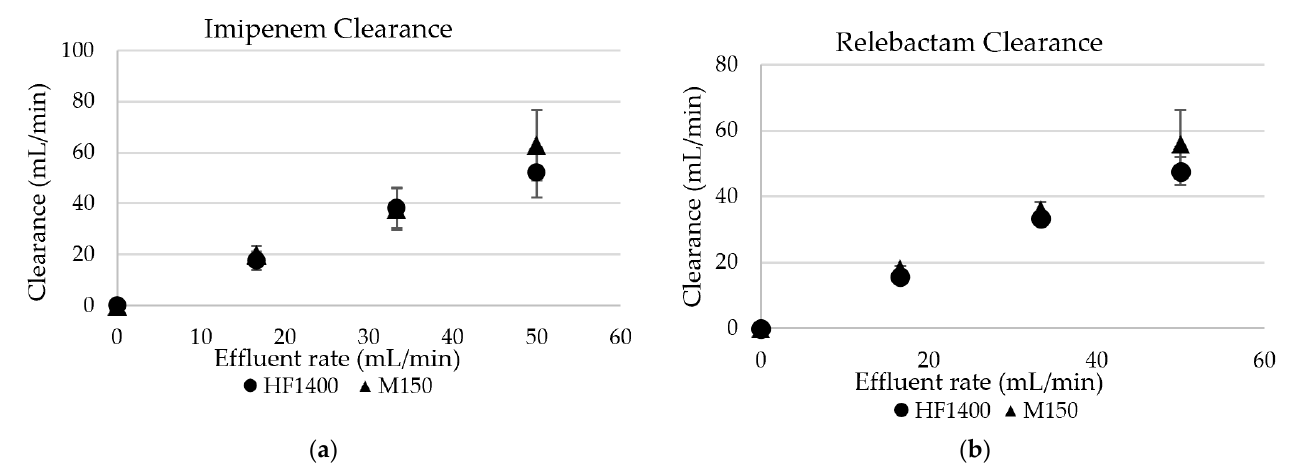
Figure 1. ( a ) Imipenem continuous hemofiltration transmembrane clearance. ( b ) Relebactam continuous hemofiltration transmembrane clearance.